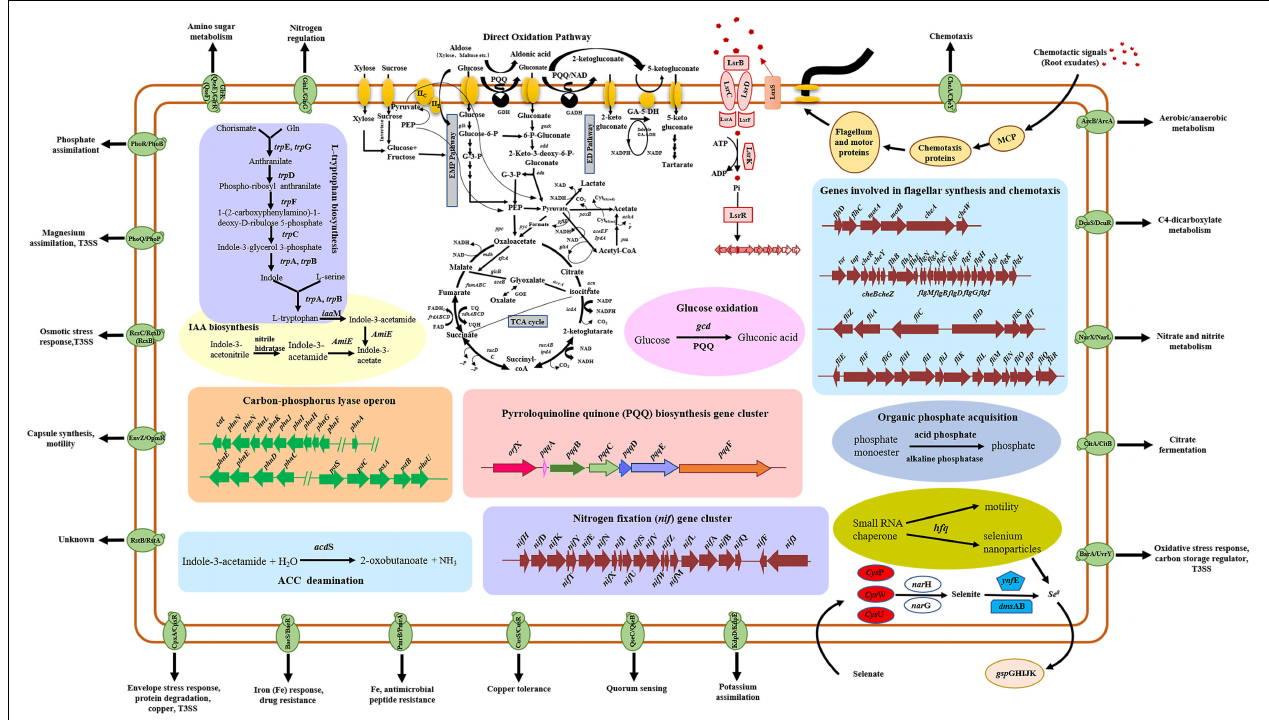
FIGURE 5 | Metabolic pathway map of R. aceris ZF458 related to plant growth promotion and environmental adaption.